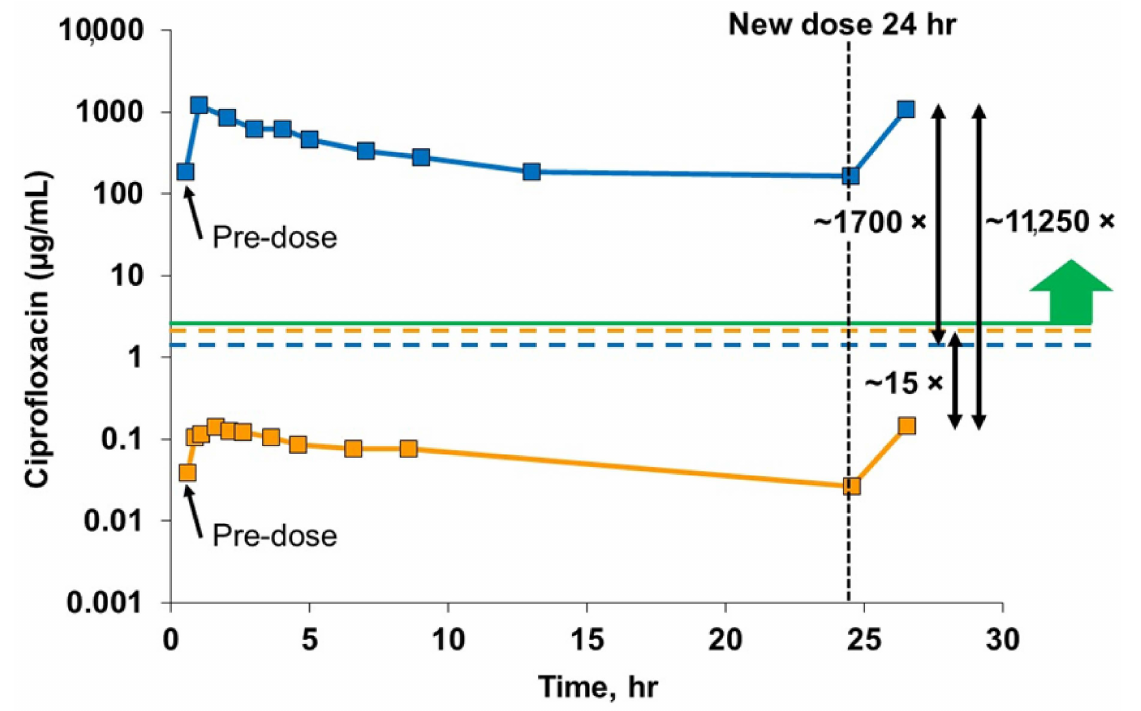
Figure 6. Ciprofloxacin concentrations in blood and sputum samples at steady state. These results cover a single dosing interval over a 24-h period from the Phase 3 open label extension. These data are at steady state achieved after about 4 days of dosing. The solid blue line shows the very high sputum concentrations of ciprofloxacin achieved with inhaled liposomal ciprofloxacin, three orders of magnitude above the MIC for PA (green line) throughout the 24-h dosing interval, and well above the Cmax for oral ciprofloxacin in sputum (dotted blue line). This solid orange line shows a far lower plasma concentration of ciprofloxacin for inhaled liposomal ciprofloxacin, one order of magnitude lower than the Cmax for oral ciprofloxacin (dotted orange line). The peak sputum concentration of ciprofloxacin for inhaled liposomal ciprofloxacin is over 10,000 × higher than the peak plasma concentration. Adapted from [135]. World Bronchiectasis Conference,